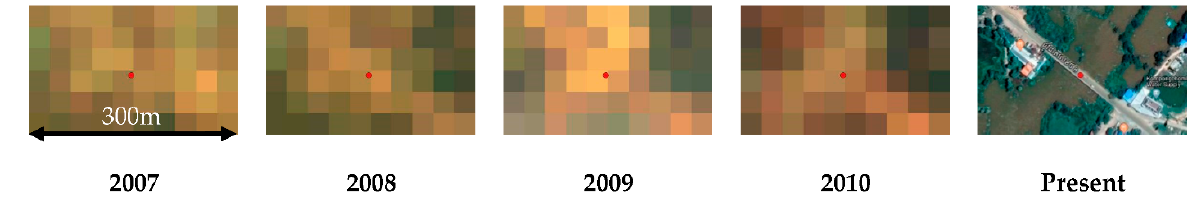
Figure 17. Satellite images of Prey Bang bridge; low image quality means the year of construction cannot be judged.